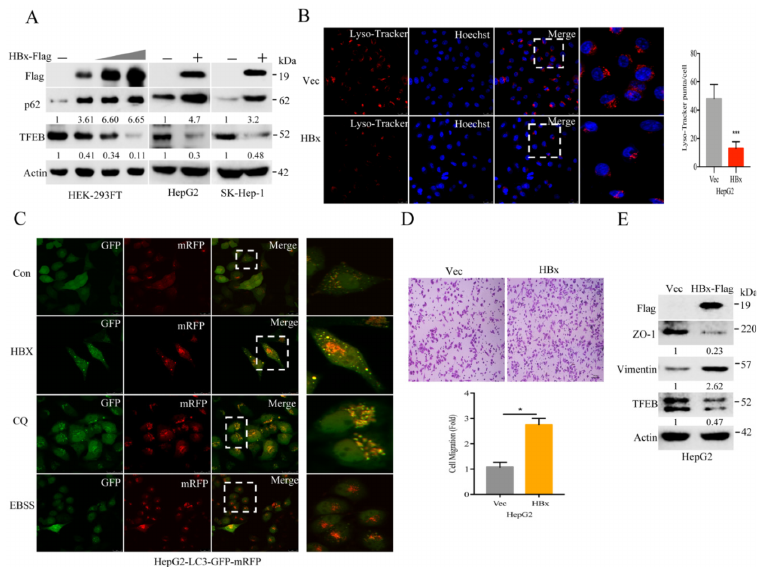
Figure 2. Hepatitis B virus X protein (HBx) suppresses the expression of TFEB and impairs lysosome biogenesis. ( A ) HepG2 or SK-Hep-1 cells stably expressing HBx and HEK-293FT were transfected with vector control or 0.5, 1, or 2 µ g of HBx plasmid, followed by Western blotting analysis. ( B ) Lyso-Tracker staining assay. HepG2 cells stably expressing vector (Vec) or HBx were treated with 100 nM Lyso-Tracker for lysosomes followed by confocal microscopy analysis. The experiment was repeated three times and five visual fields were counted for statistics. ( C ) HepG2 cells stably expressing LC3-tandem-mRFP-GFP were further infected with HBx lentivirus or treated with EBSS medium for 6 h, or chloroquine at 50 µ M, for 12 h, followed by confocal microscopy analysis. ( D ) HepG2 cells stably expressing vector (Vec) or HBx-Flag were subjected to transwell assay. The experiment was repeated three times and five visual fields were counted for statistics; ( E ) HepG2 cells stably expressing vector control (Vec) or HBx-Flag were subjected to Western blotting analysis for ZO-1, vimentin, TFEB, and actin. For (B) and (C), scale bar = 25 µ m; for (D), scale bar = 100 µ m. * p < 0.05 and *** p <